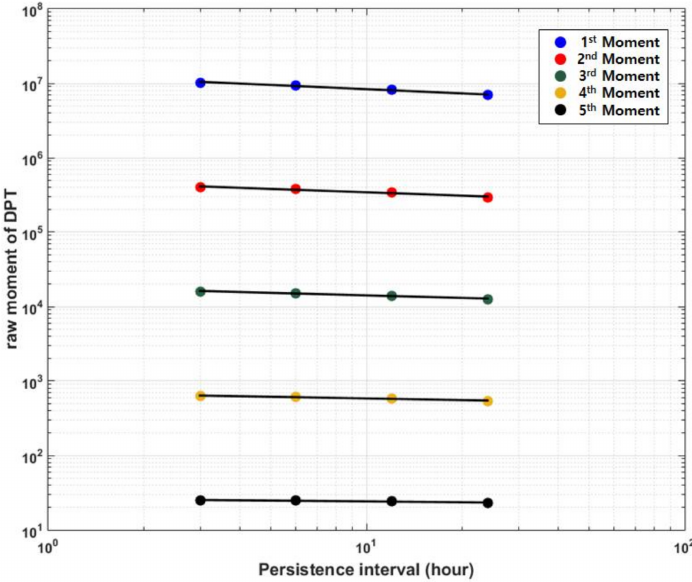
Figure 4. The relationship between the values of moment and dew-point temperature persistence interval at Seoul station in the first half of